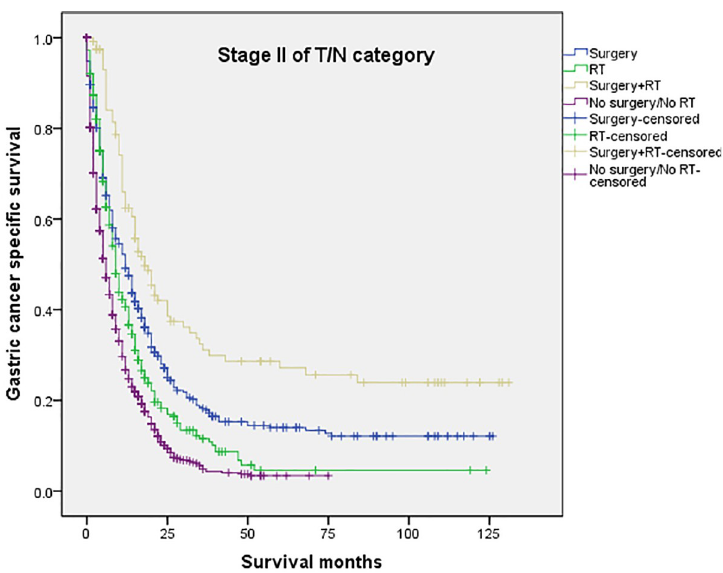
Fig 3. Survival curves in patients with advanced gastric cancer according to four subgroups in stage II of T/N category (P < 0.001). RT: radiation.